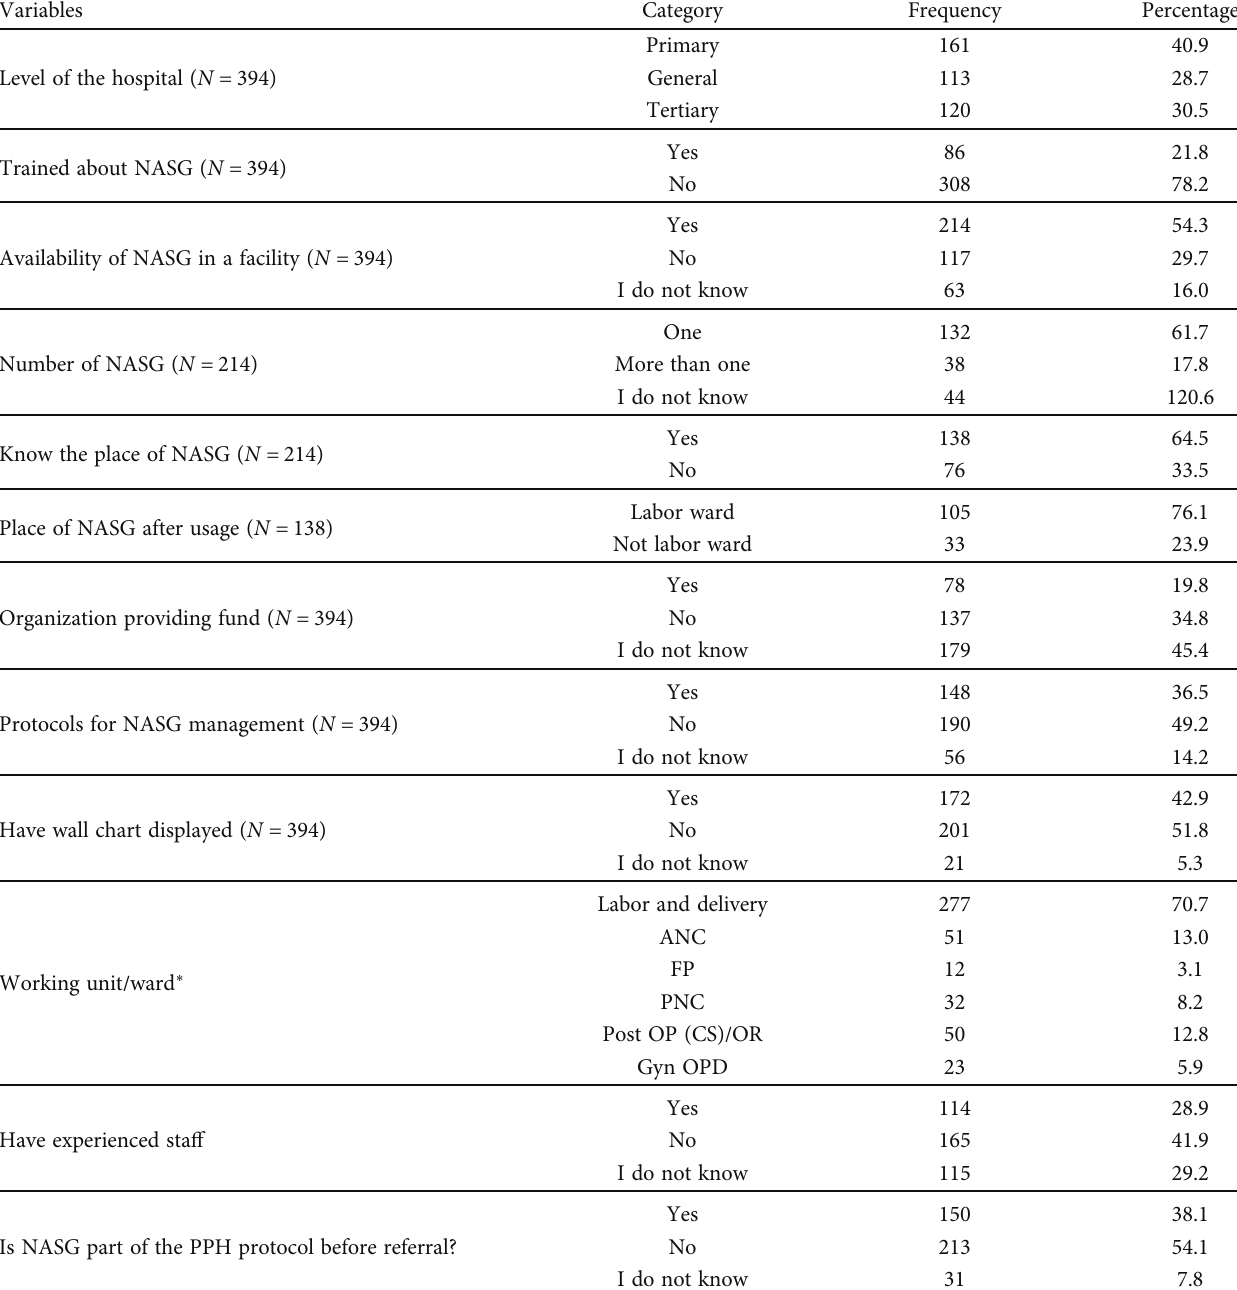
Table 2: Facility-related characteristics of obstetric care providers who participated in the study and worked in public hospitals of Sidama region, Ethiopia, 2022 ( N = 394